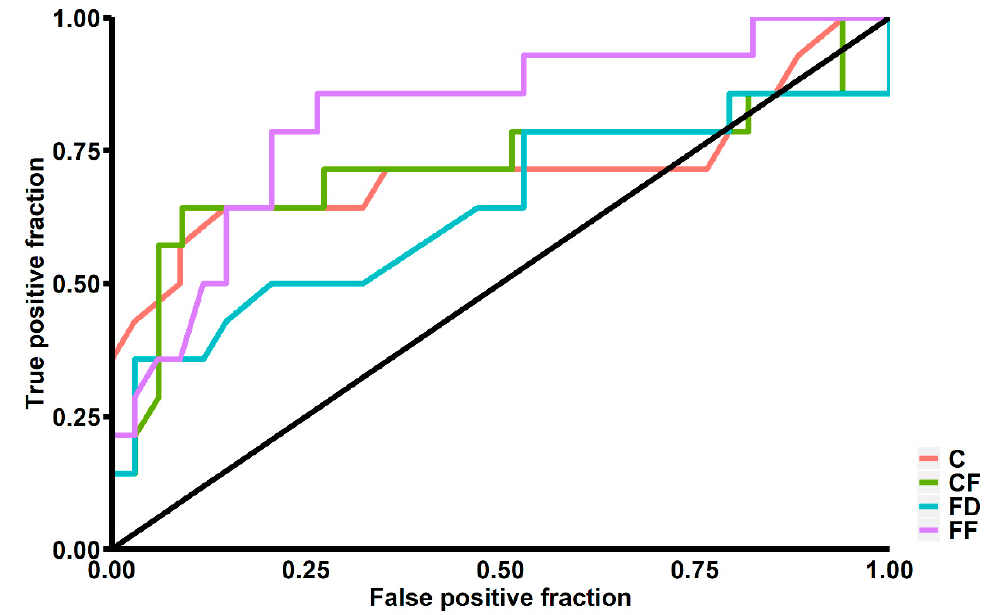
Figure 2. Receiver operating characteristics graph for sensitivity and specificity of intracerebral hemorrhage growth prediction. C—Compactness, CF—Circle Factor, FD—Fractal Dimension, FF—Fourier Factor.